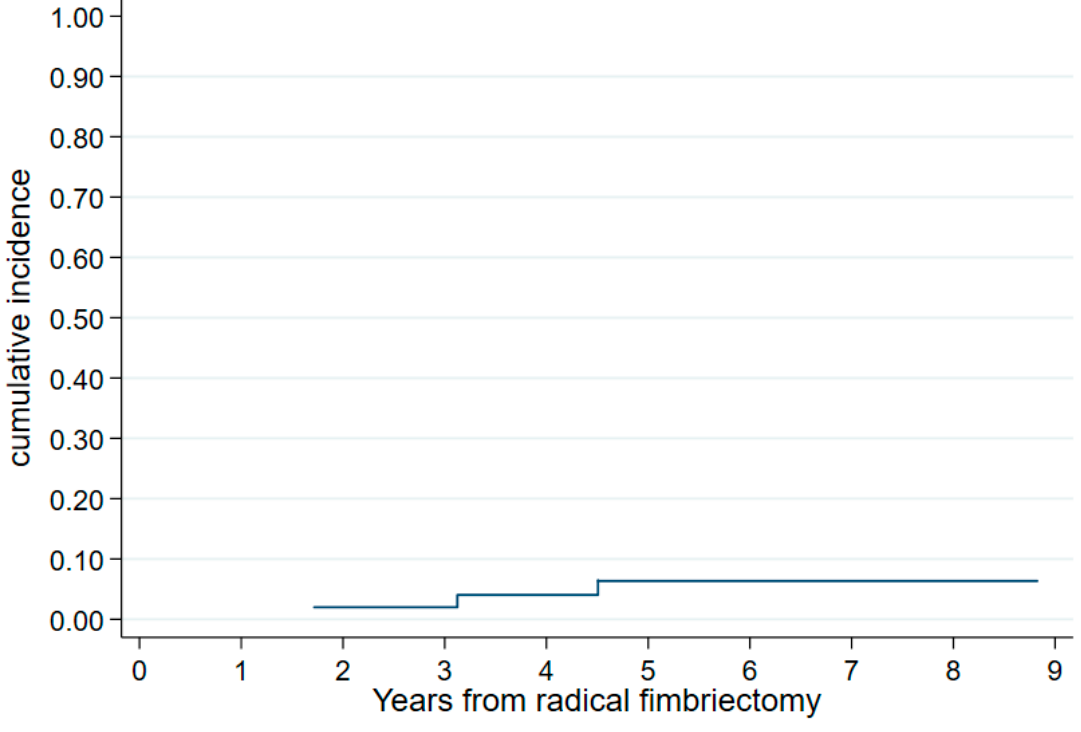
Figure 3. Cumulative incidence of breast cancer from radical fimbriectomy in patients with no personal history of breast cancer (N = 52).